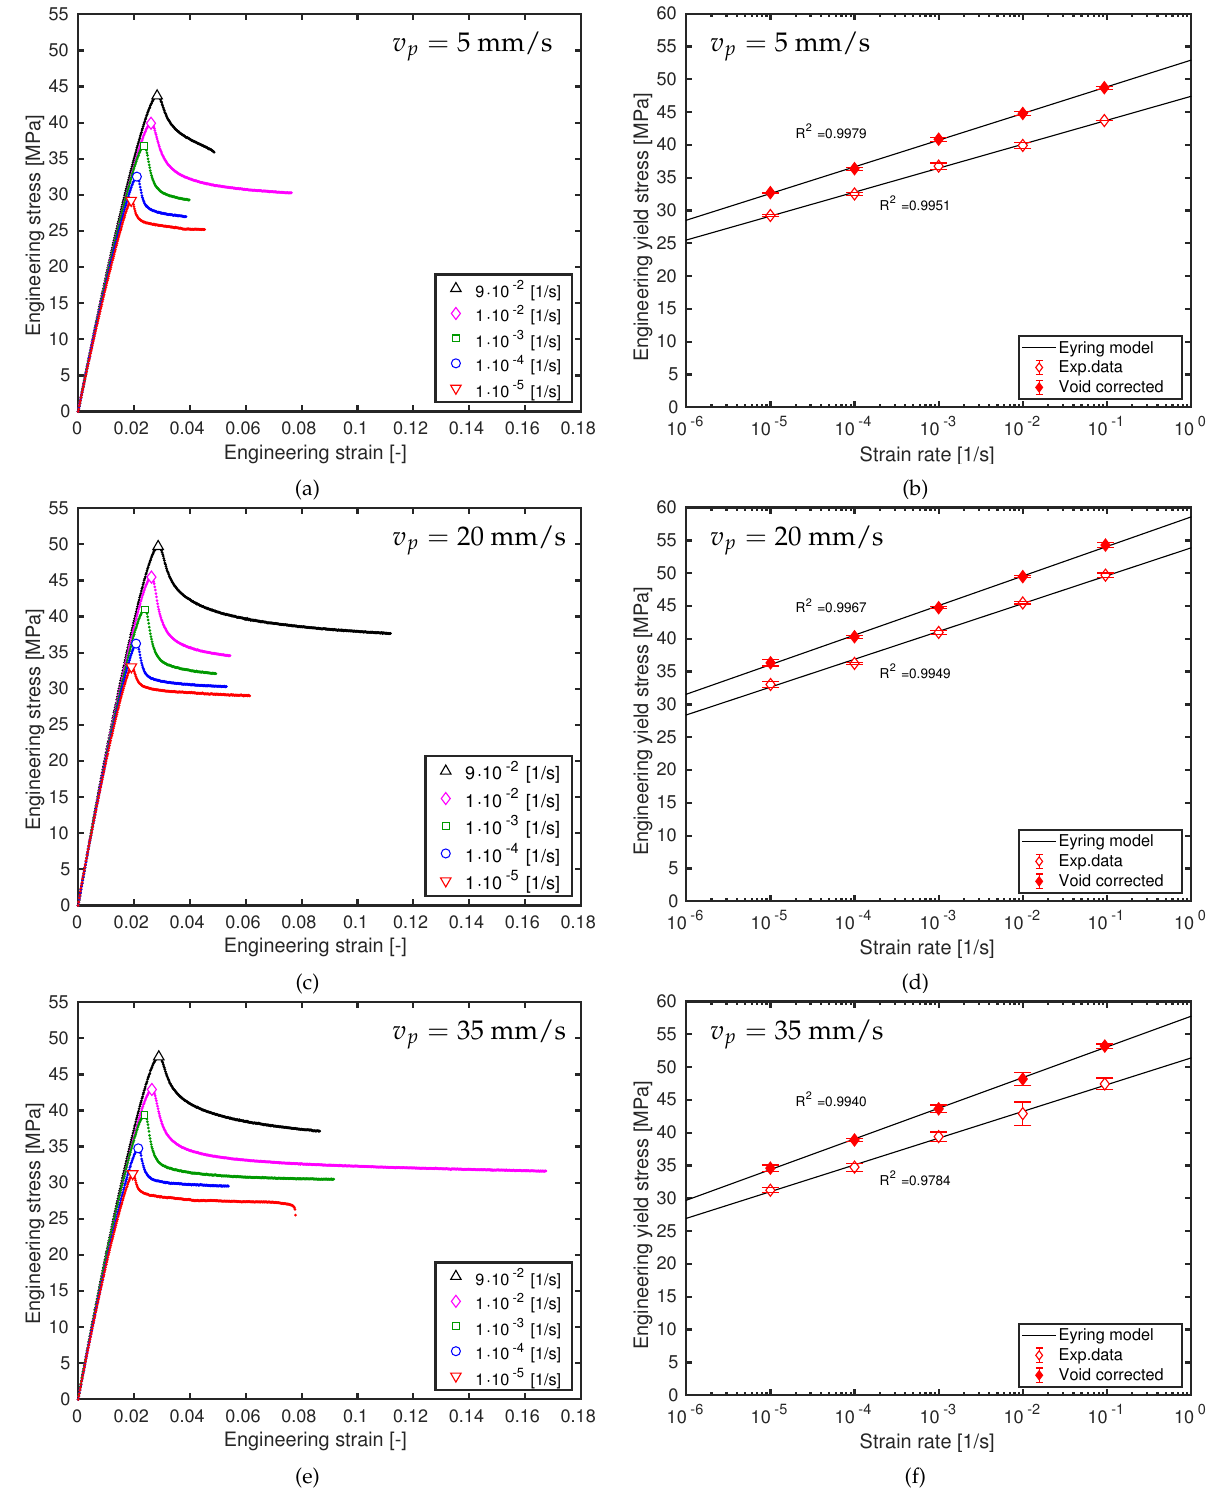
Figure 2. Engineering stress/strain response of ABS samples at 3 printing velocities. ( a , c , e ) stress as a function of strain. Symbols are experimental yield stress values; ( b , d , f ) yield stress and void corrected yield stress as a function of logarithmic strain rate. Symbols are experimental results, solid lines are model predictions. ( a , b ) v p = 5 mm/s; ( c , d ) v p = 20 mm/s; ( e , f ) v p = 35 mm/s.